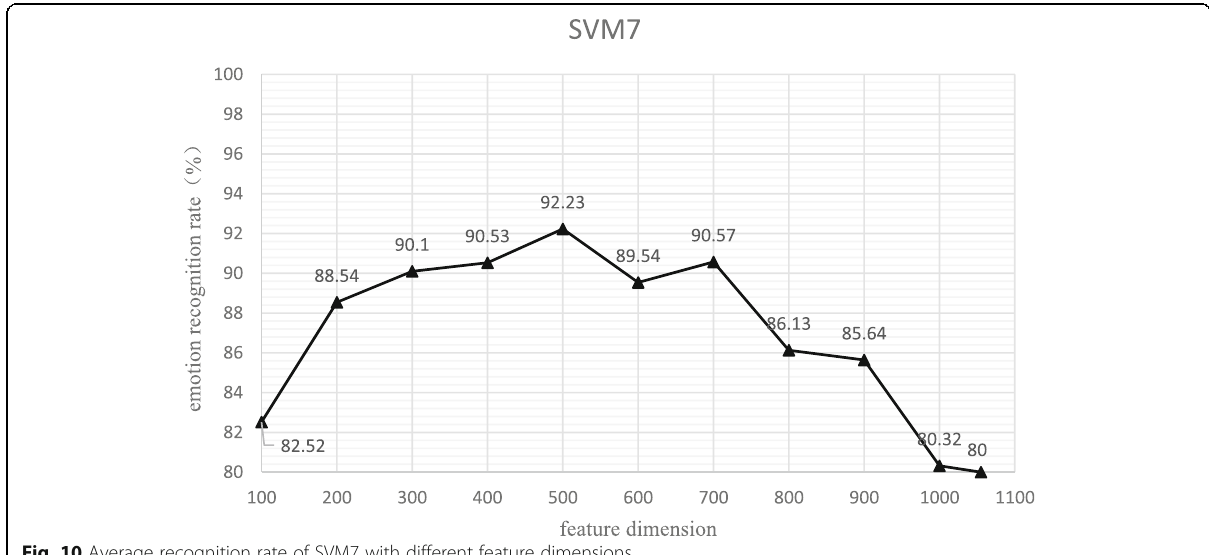
Fig. 10 Average recognition rate of SVM7 with different feature dimensions